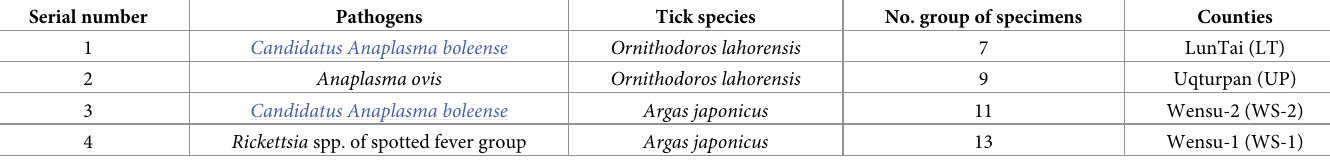
Table 2. A summary of the pathogens found in the argasid ticks of southern